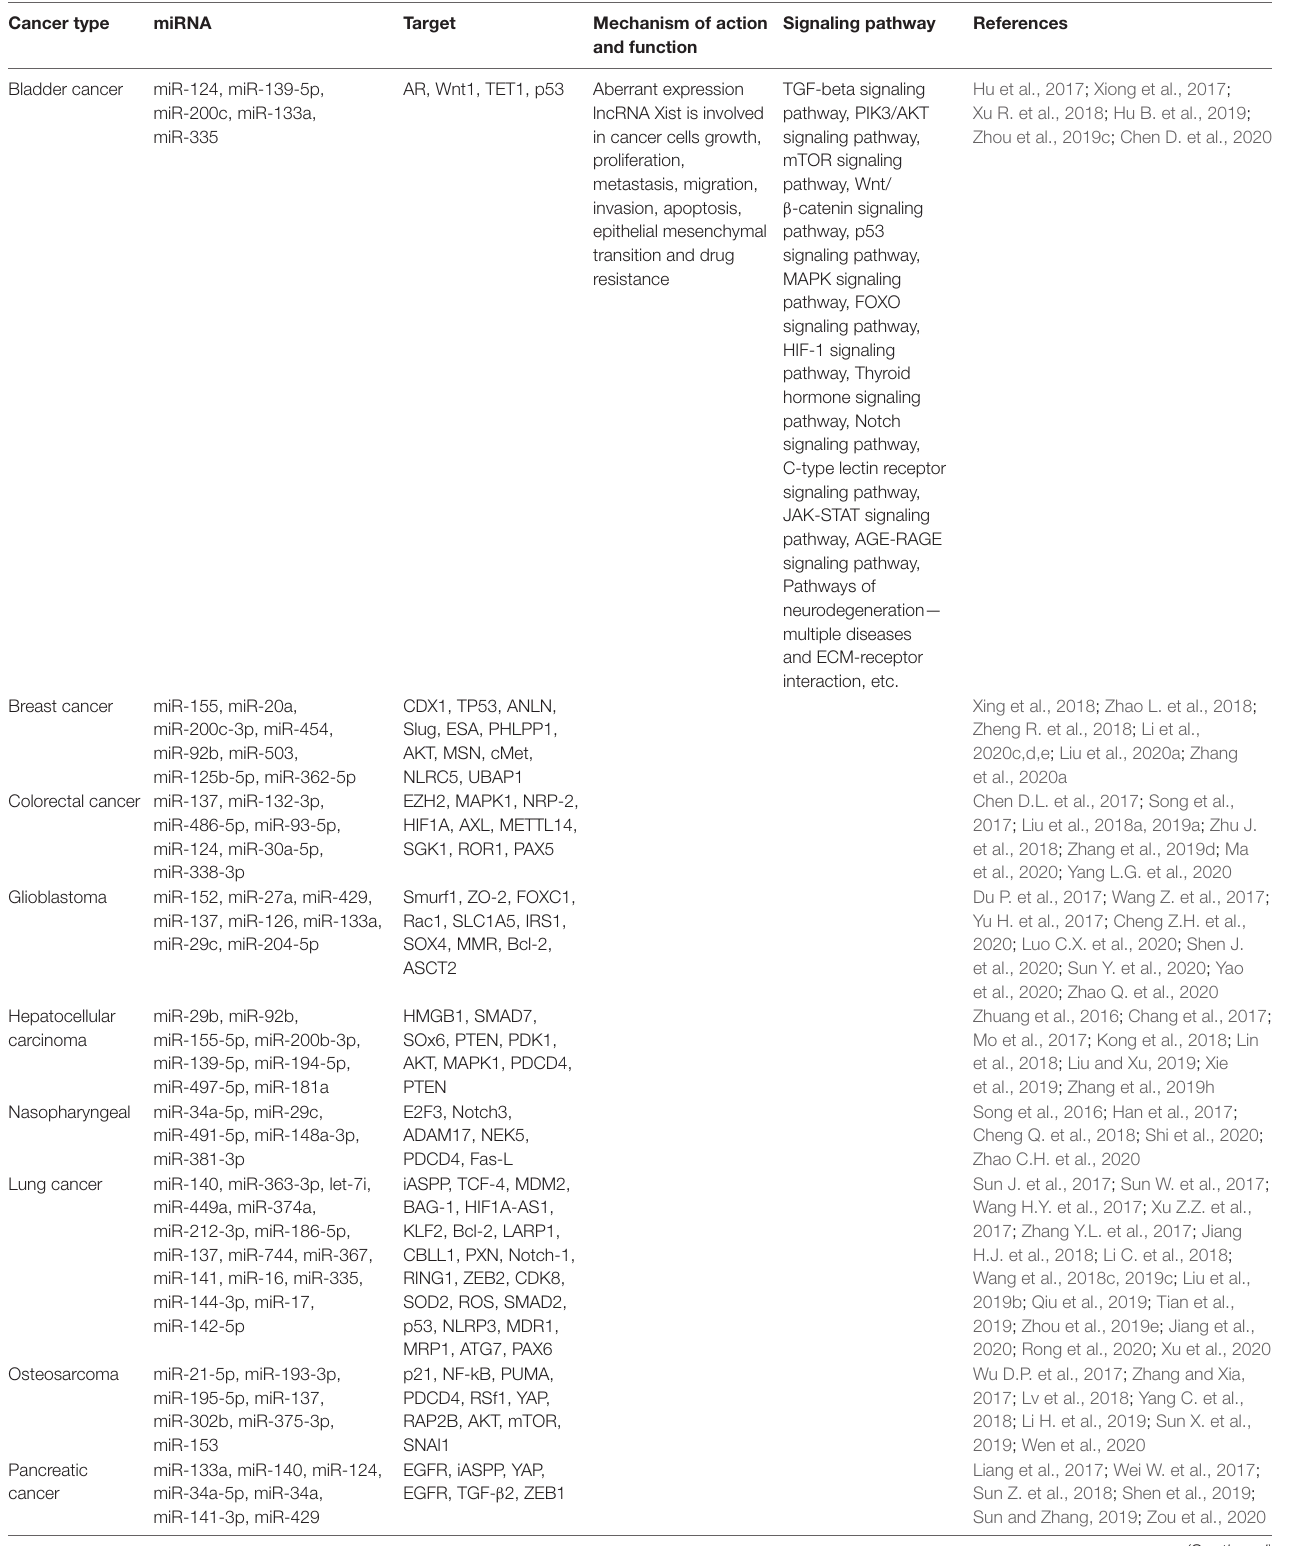
TABLE 1 | LncRNA Xist and miRNA in